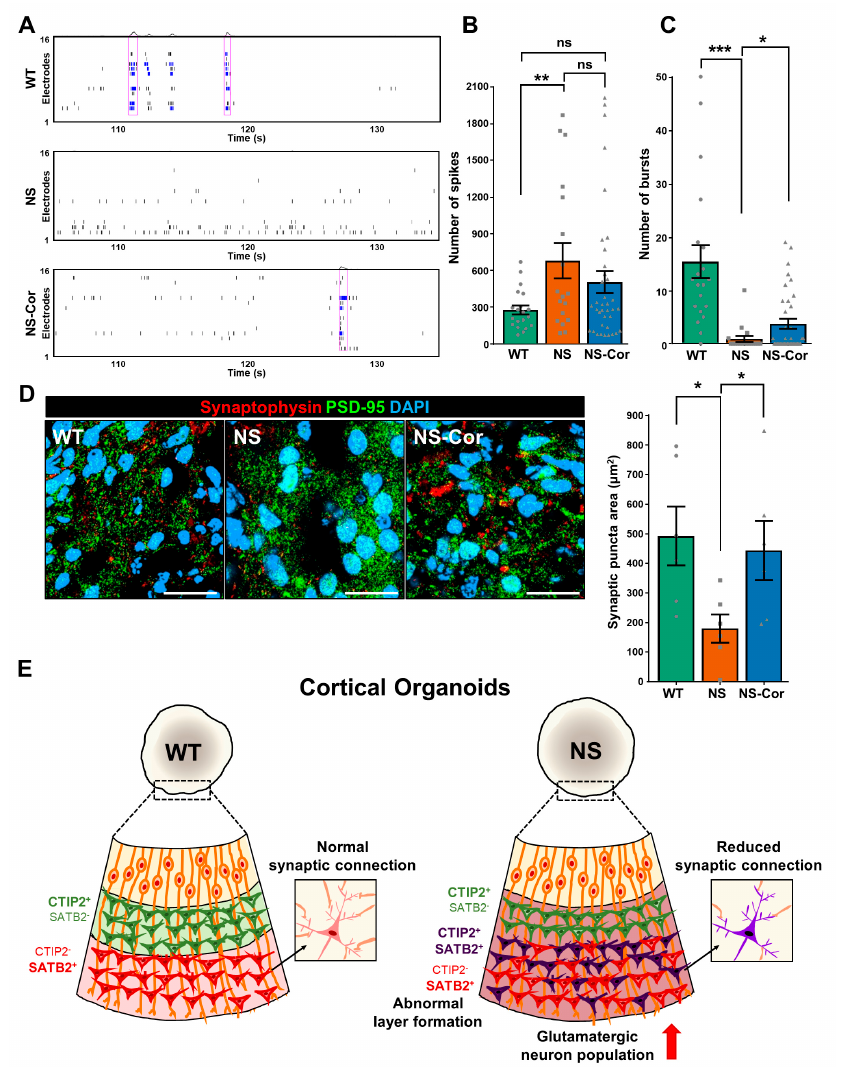
Figure 4. Aberrant neuronal connectivity in NS-COs. ( A ) Raster plot of extracellular spontaneous firing in week 24-COs. Blue lines indicate bursts and purple boxes represent network bursts. ( B ) Number of spikes in COs. Numbers of spikes and bursts were counted in 18–37 active elec- trodes. Active electrodes are defined as electrodes that exhibit more than 5 spikes per min. The number of spikes was analyzed using Axis navigator software. ( C ) Number of bursts in respective COs. The number of bursts was also analyzed using Axis navigator software. ( D ) Reduced area of synaptic puncta in NS-COs. Areas showing co-localization between synaptophysin and PSD-95 were counted in six organoids per group using Fiji software. COs were obtained from three independent experiments. Scale bars, 20 µ m. ( E ) A schematic model of the neurodevelopmental defects in NS-COs. In ( B – D ), data are presented as means ± SEM. p -values were determined using an unpaired Student’s t -test. * p < 0.05; ** p < 0.01; *** p <